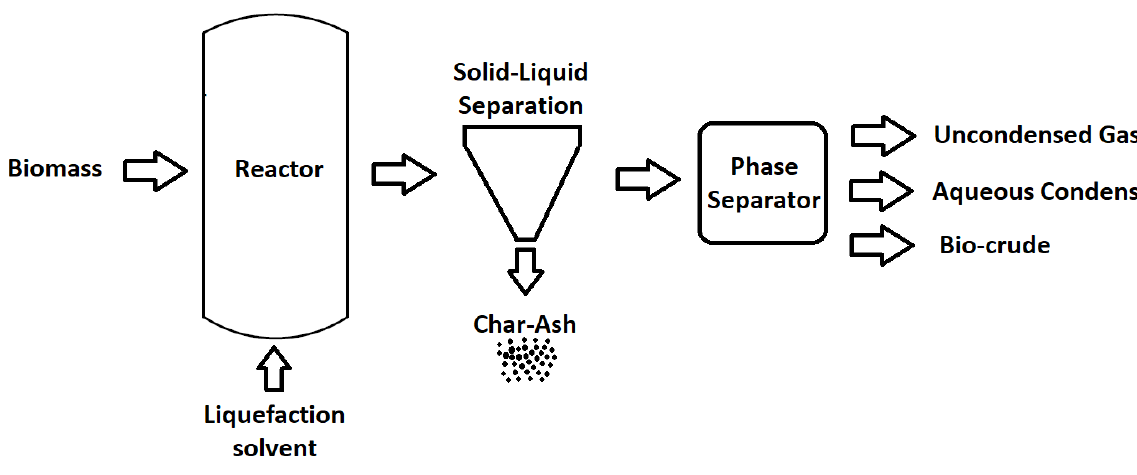
Figure 4. Liquefaction system scheme, own source based on the diagrams in [106,107].